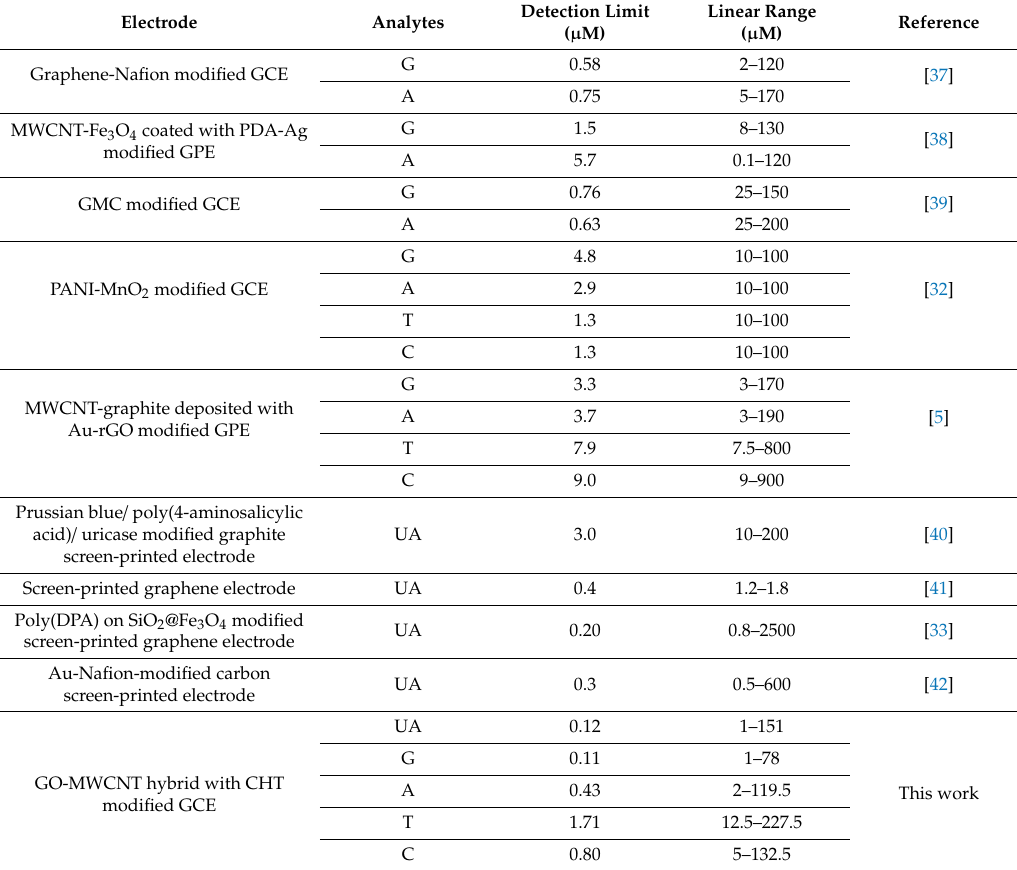
Table 2. Comparison of the nanocomposite-modified sensor with the ones recorded in the literature for the detection of all four